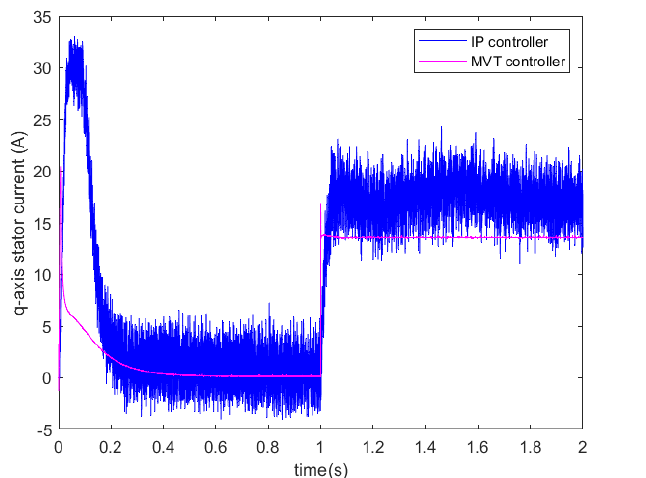
Figure 7. q-axis current waveform under two controllers.